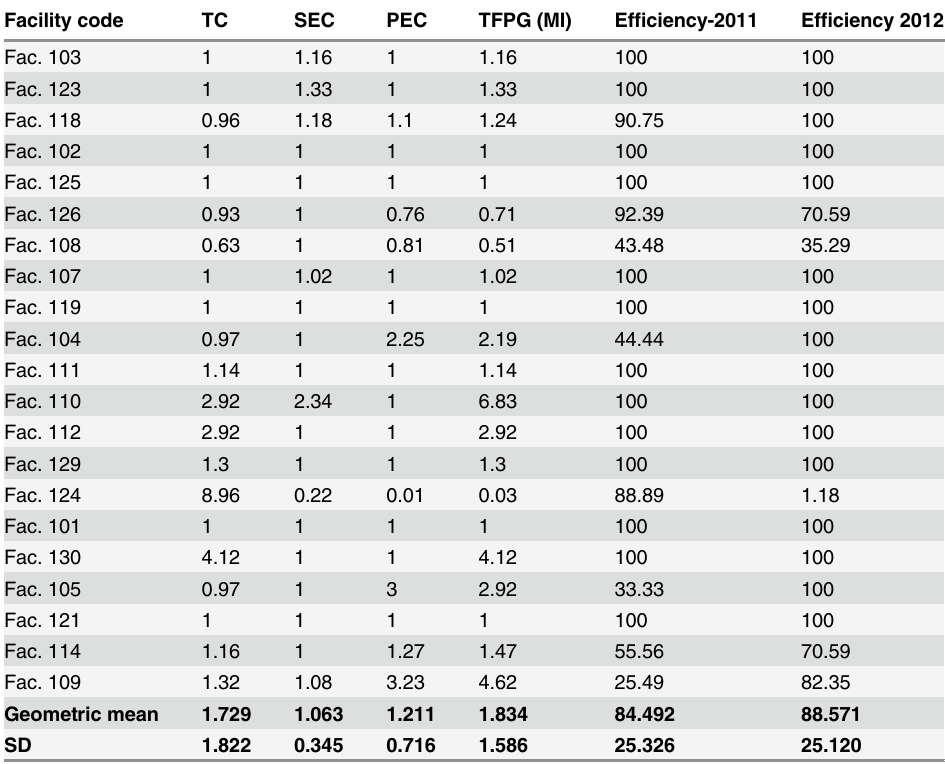
Table 7. Productivity performance for each service delivery facility by